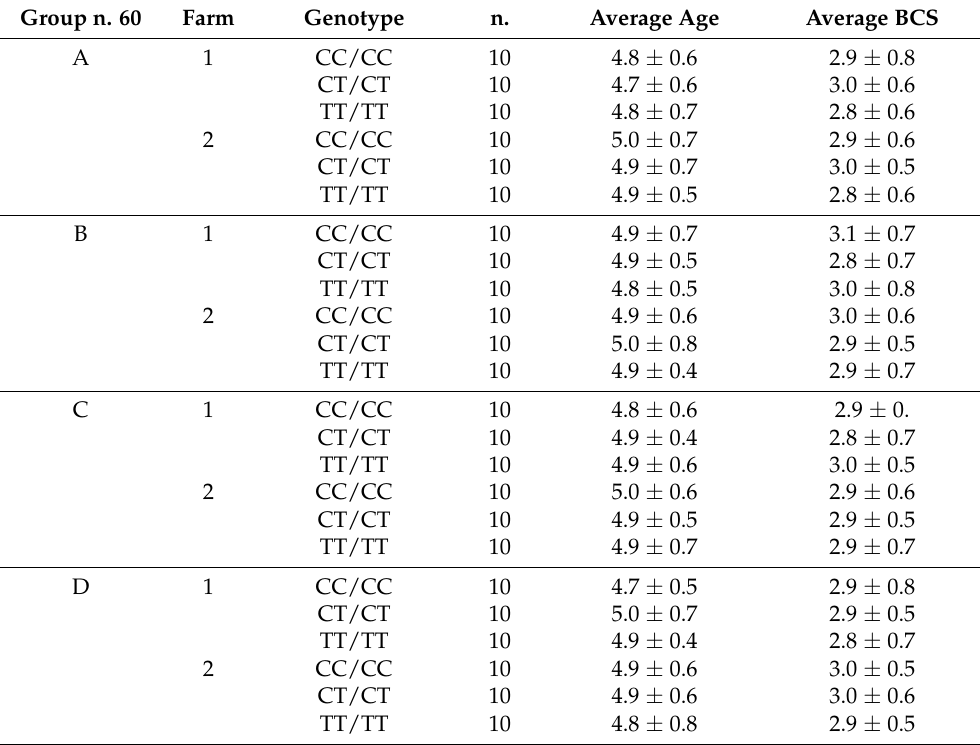
Table 1. Groups (month of ram introduction), number of animals per group, genotypes per group, number of animals per genotype, average of age and BCS for each genotype inside of the groups. Group n. 60 Farm